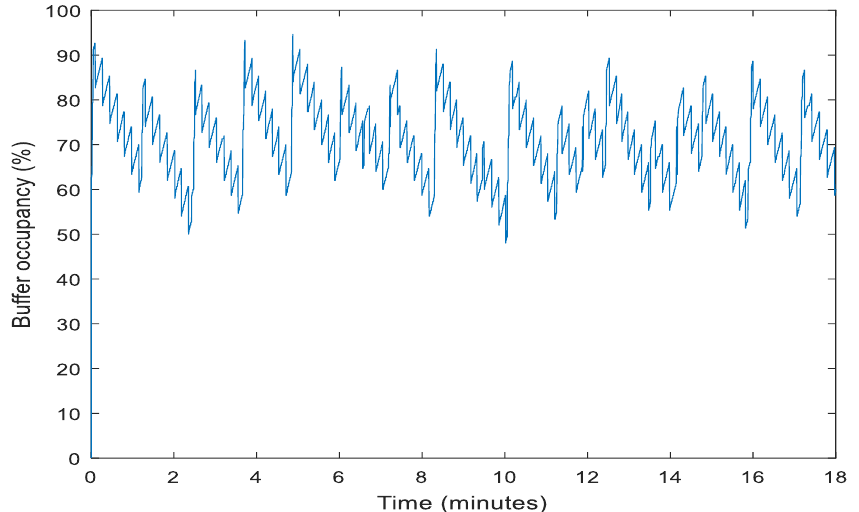
Figure 10. Buffer occupancy with DCCP at 0.2 Mbps.